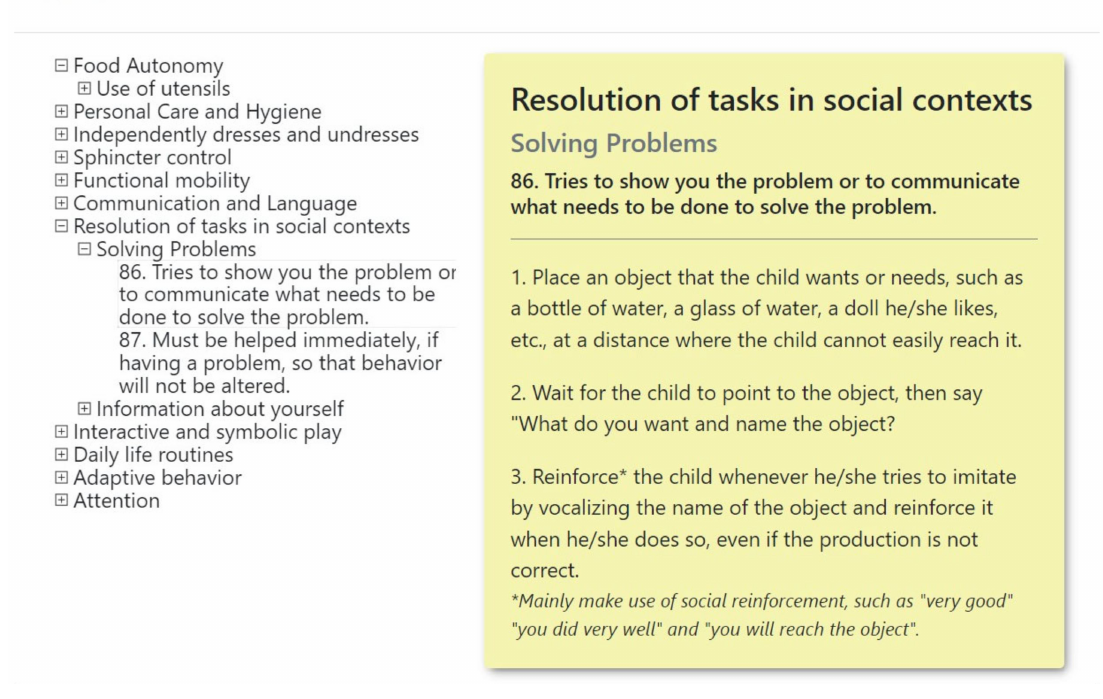
Figure 6. Example of guidance cards for implementation of a functional ability.